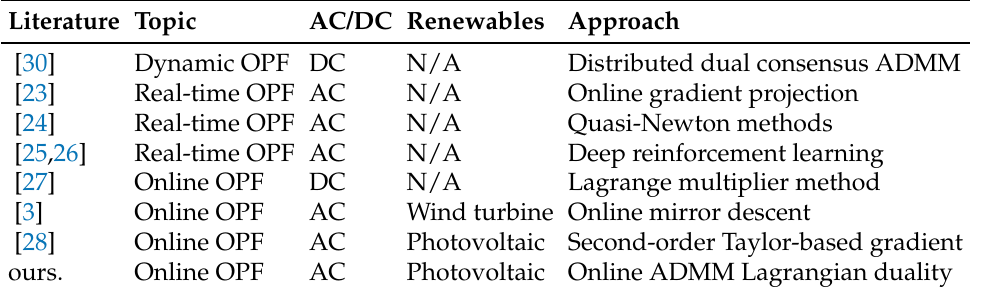
Table 1. Comparisons of the proposed algorithm with the existing distributed online